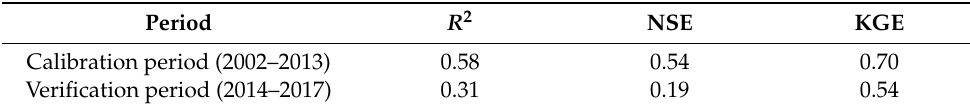
Table 2. Evaluation result of simulated daily flow of each year.